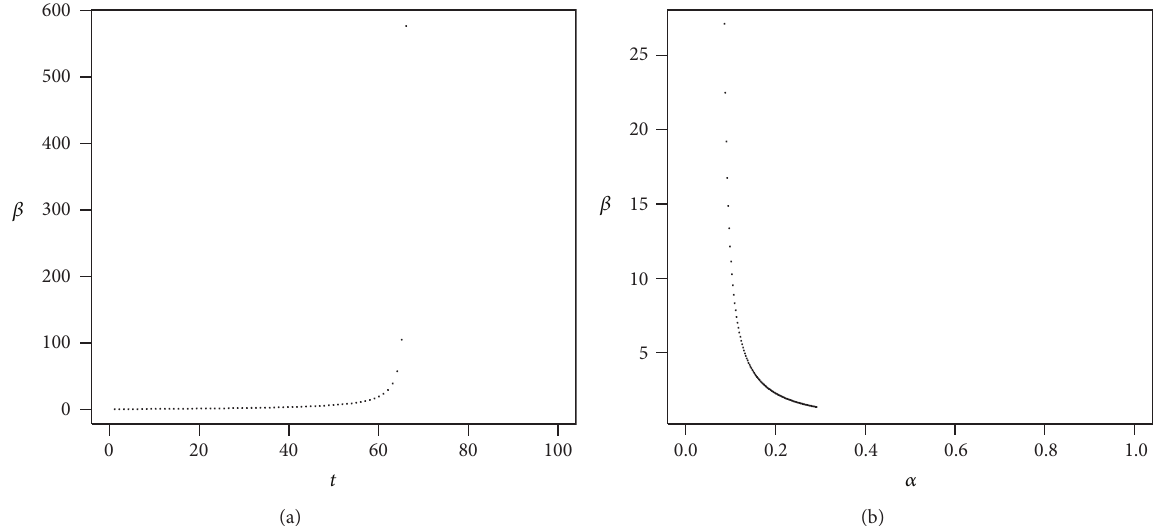
Figure 10: High volatility of returns (optimistic). The plot shows 𝛽 as a function of 𝑡 with 𝛼 = 50 % (a) and 𝛽 as a function of 𝛼 with 𝑡 = 40 (b). Parameters are 𝑟 = 4 %, 𝜇 = 23.5 %, 𝜎 = 75 %, ] = 3.1 %, and 𝛾 = 10